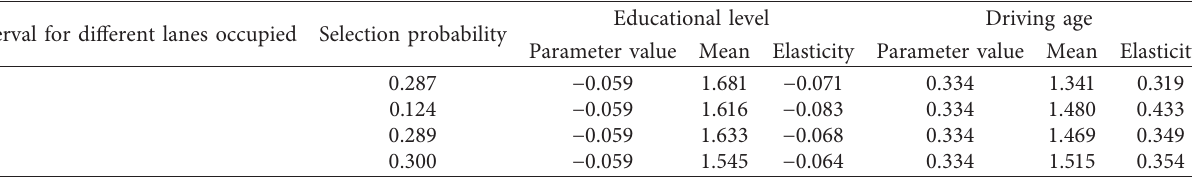
Table 10: Calculation results on the educational level and driving age.